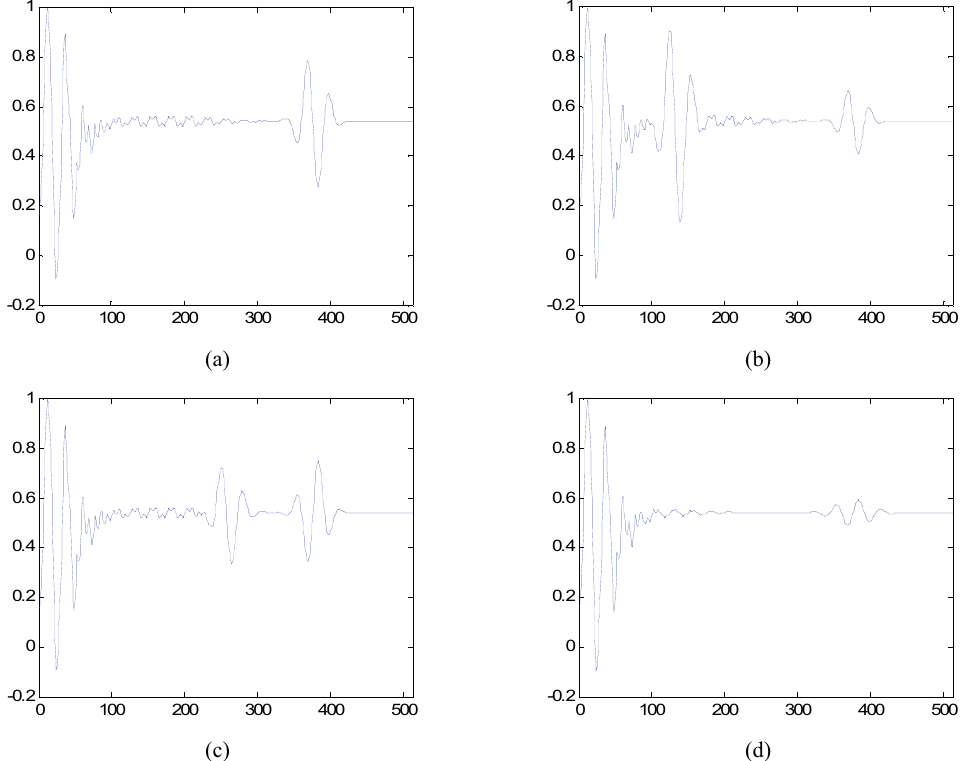
Fig. 3. Four kinds of signals (a) No flaw (b) Delamination (c) Debonding (d)